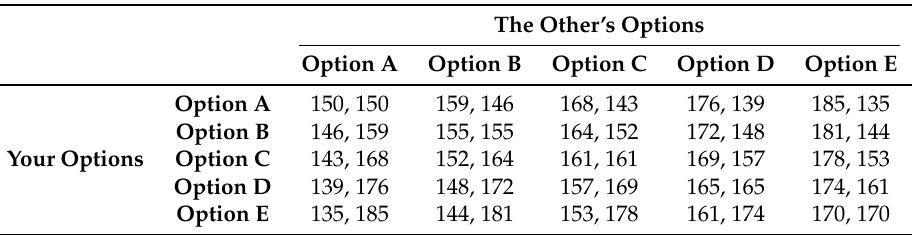
Table A7. Recomposition of task number six into a matrix